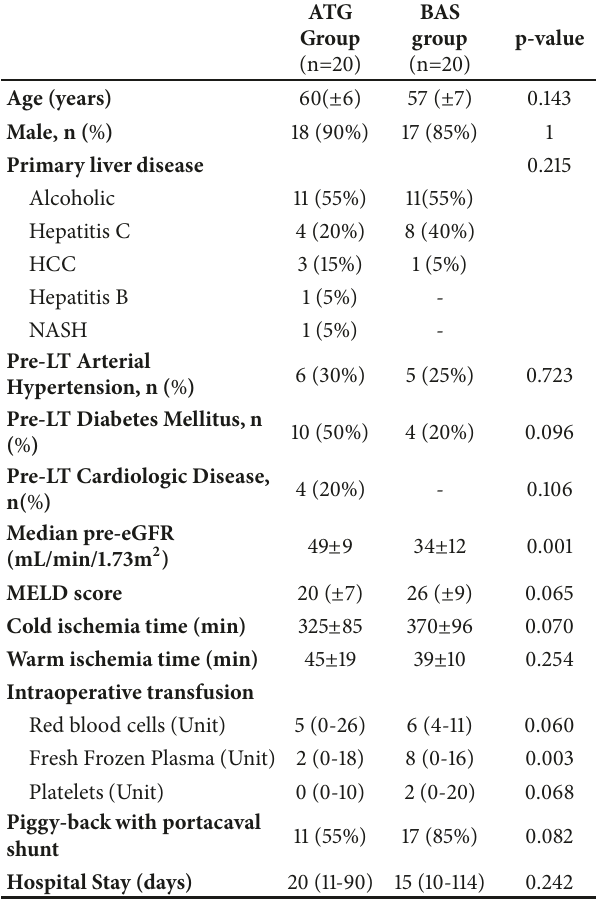
Table 1: Patient characteristics and surgical